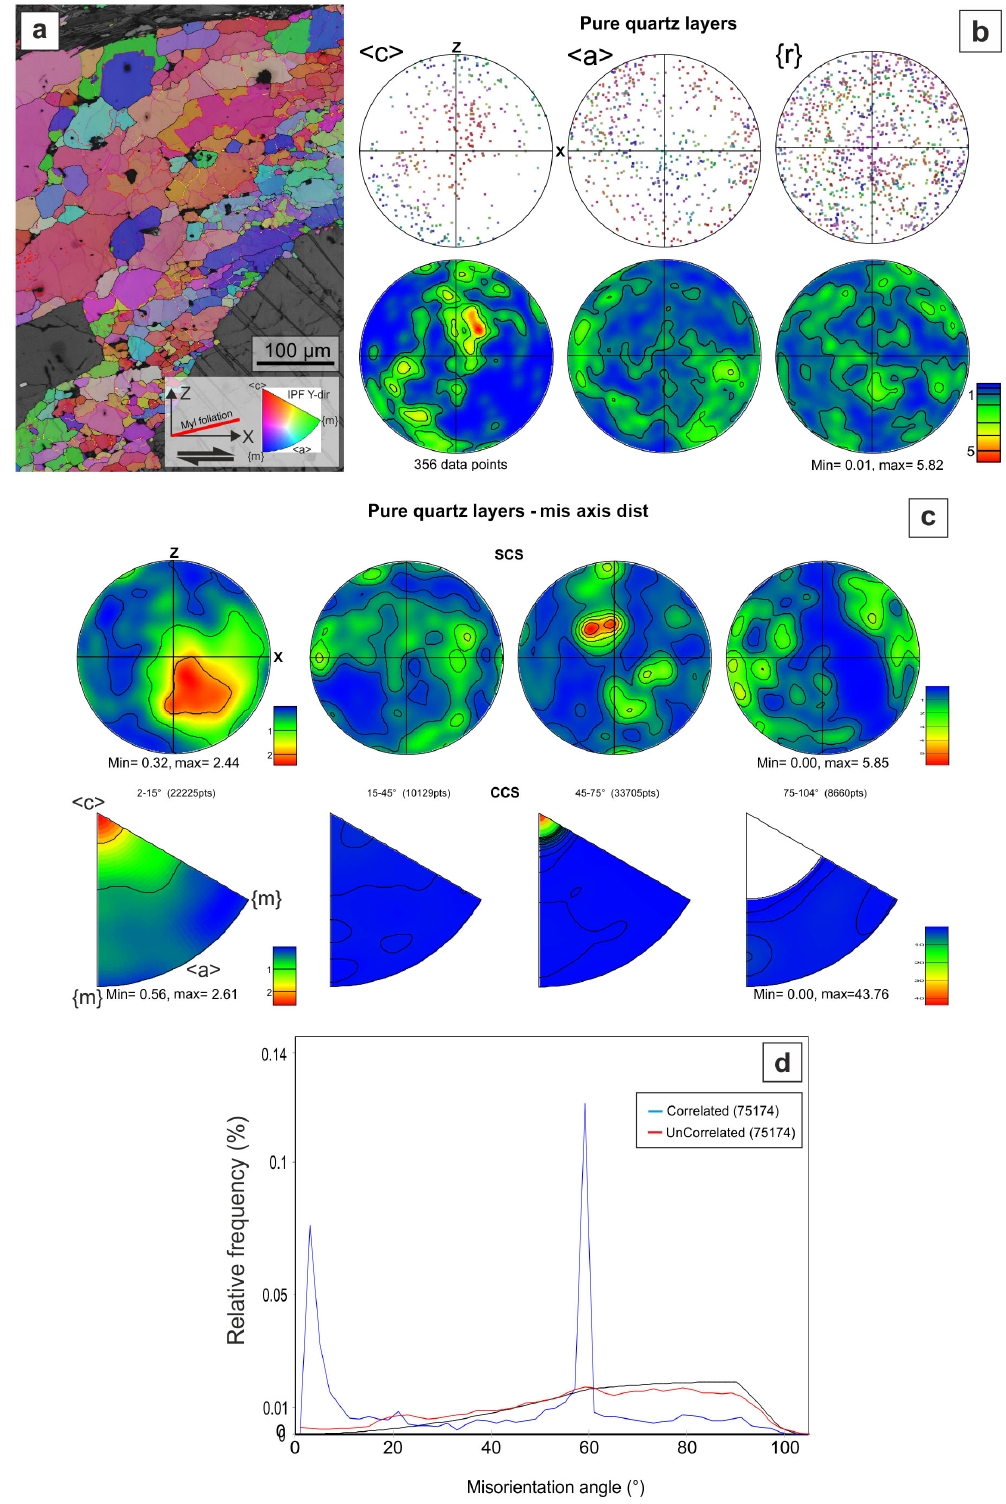
Figure 5. EBSD orientation data and mapping for pure Qtz layers. (a) Orientation map colour coded according to the inverse pole figure for Y direction reported in the lower right corner. (b) Area-weighted grain-size distribution for pure Qtz layer. (b) Pole figures for Qtz [ c ], (cid:104) a (cid:105) and { r } crystallographic elements. (c) Misorientation axis distributions in sample (upper row) and crystal (lower row) coordinate system. (d) Misorientation angle distribution for